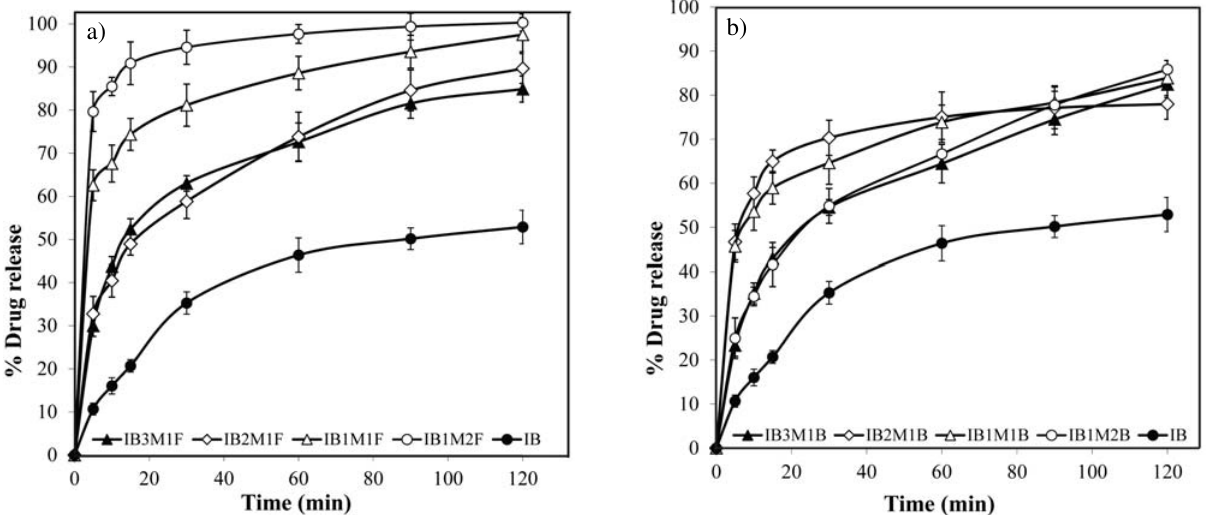
Figure 4. Dissolution profiles of co-processed ibuprofen and magnesium trisilicate: ( a ) dry-state ball-milling samples; ( b ) freeze-dried samples af- ter aqueous state equilibration (abbreviations are explained in Table 1).